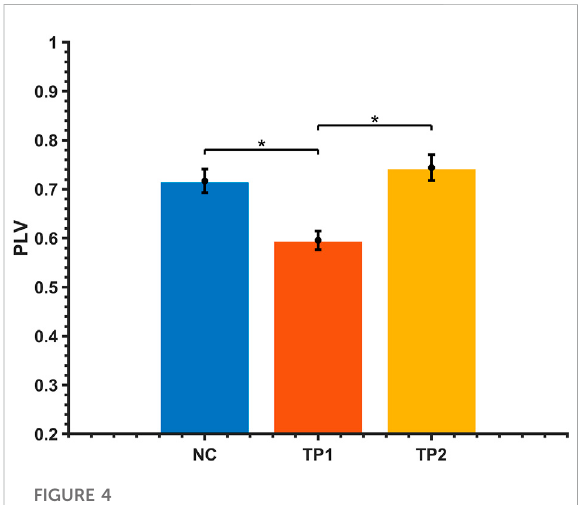
FIGURE 4 Comparison of alpha-band brain functional network connectivity in MCI patients before and after dual-target rTMS intervention with NC. *: p <